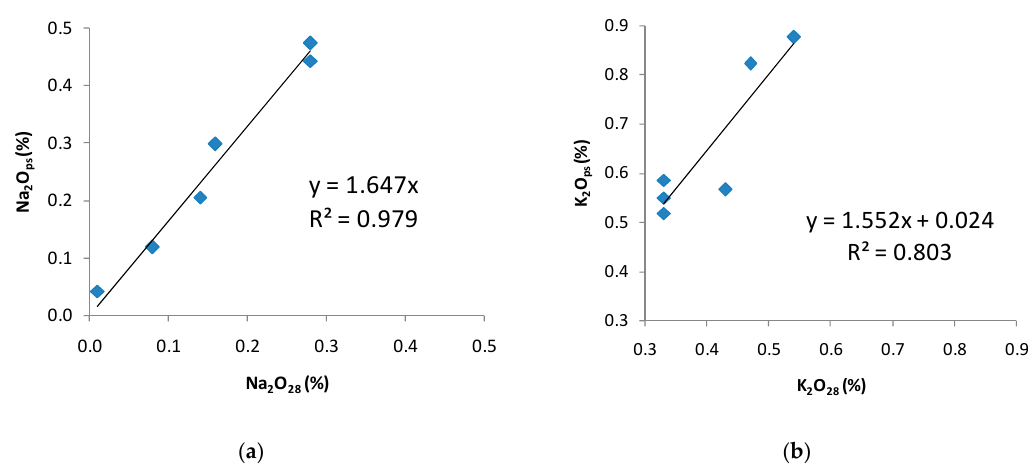
Figure 5. Relationship between the water-soluble alkalis (Na 2 O ps or K 2 O ps in the pore solution (ps)) of